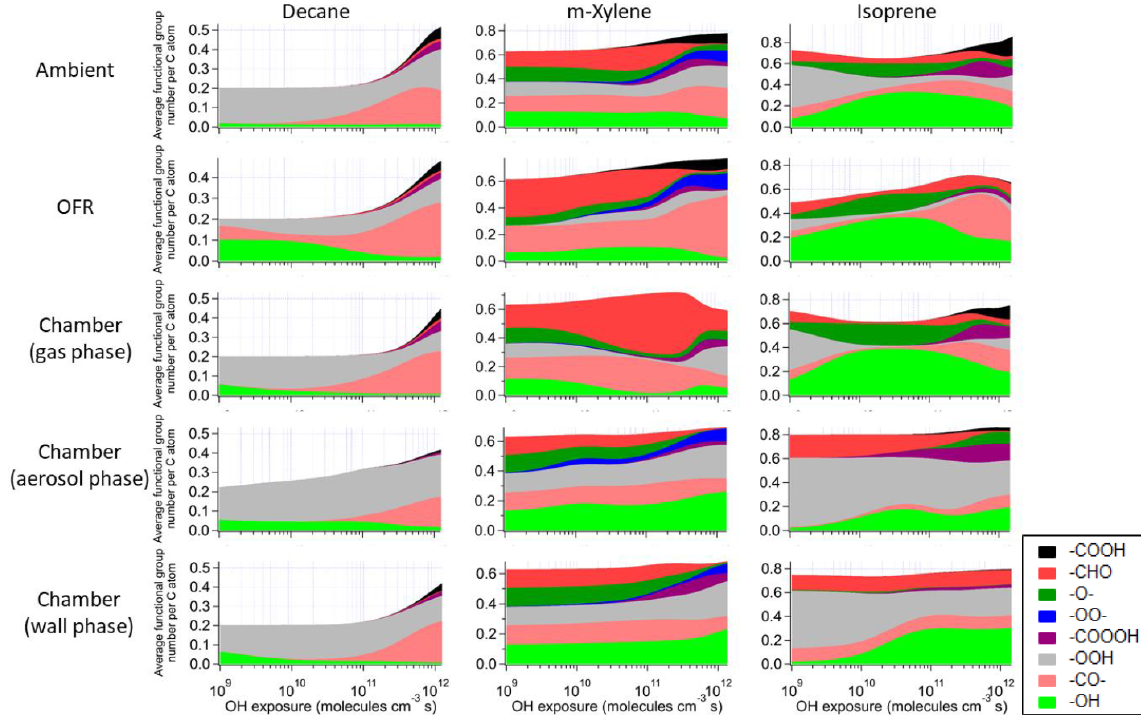
Figure 4. Average number of functional group per C atom as a function of OH exposure in the saturated multifunctional species in the ambient case with constant sunlight, the OFR case with relative humidity of 70%, high UV lamp setting, and initial OHR of 10s − 1 , as well as the gas, aerosol, and wall phases in the chamber case with initial OHR of 10s − 1 and gas–particle–wall partitioning of the photooxidations of decane, m -xylene, and isoprene. Note that the functional group “–O–” represents ether, ester, and epoxy groups in the GECKO-A